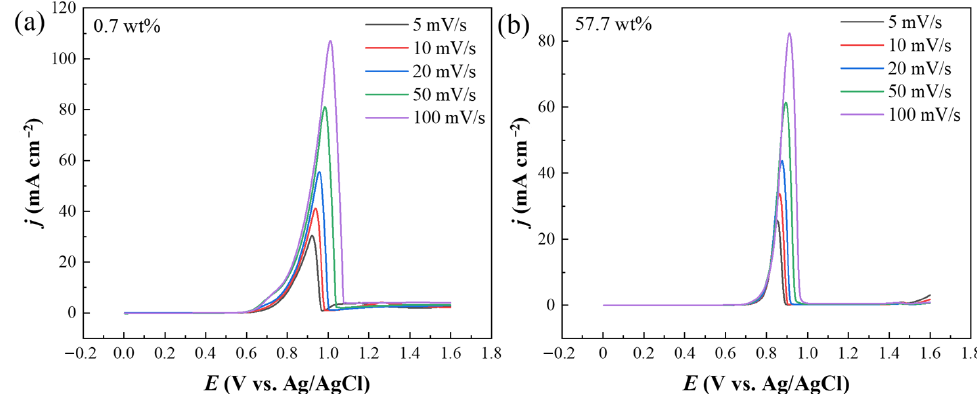
Figure 4. ( a , b ) Linear sweep voltammograms of Au electrode in ethaline with different water contents: ( a ) 0.7 wt%, ( b ) 57.7 wt%. Scan rates are 5, 10, 20, 50, and 100 mV/s.